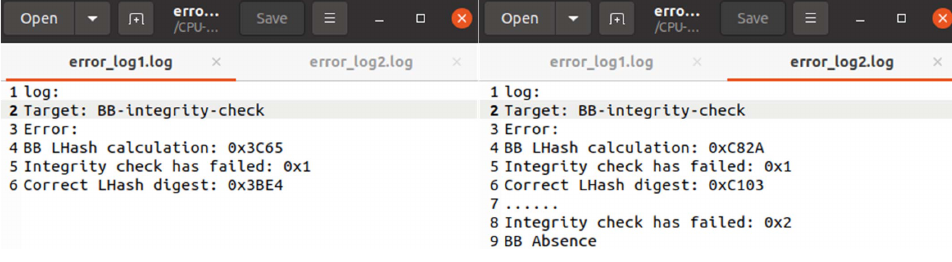
Figure 13. The output error_log files for reporting the instruction tampering behaviors in